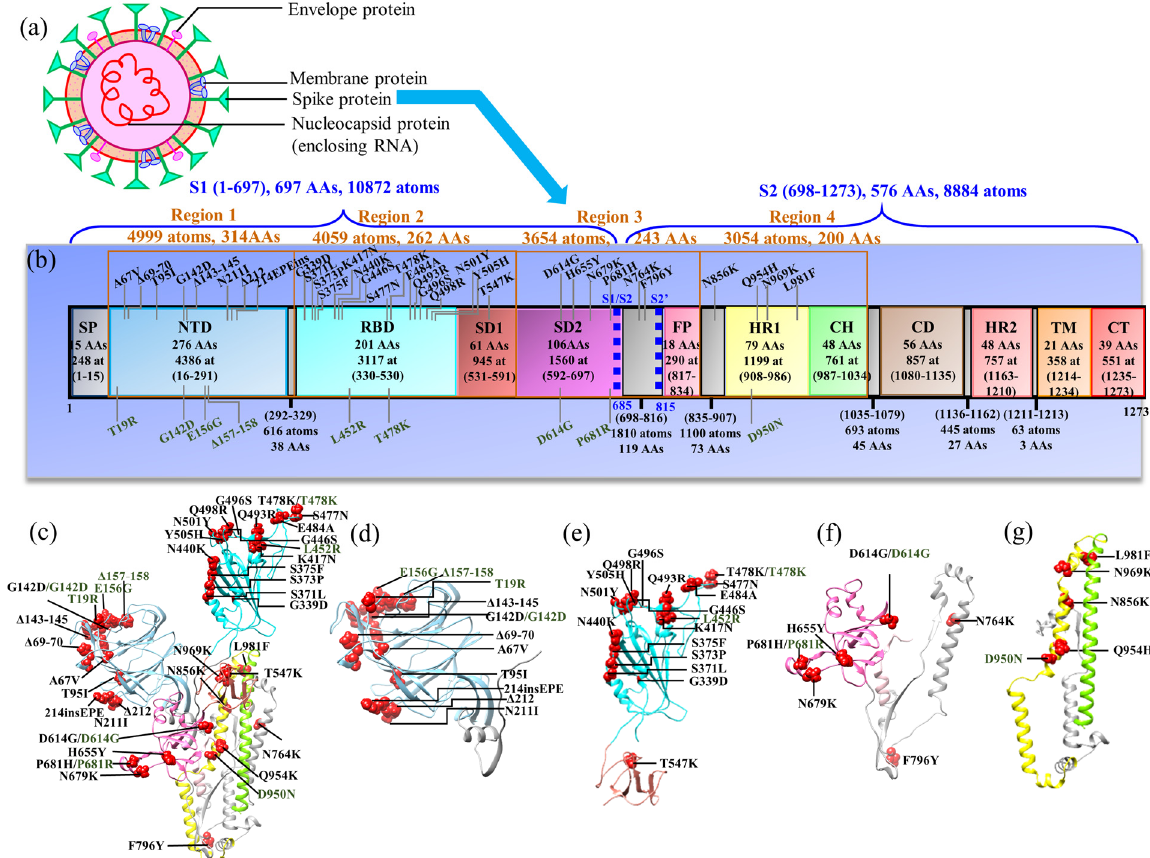
Figure 1. ( a ) Structure of SARS-CoV-2. ( b ) The schematic representation of the S-protein sequence in SARS-CoV-2 (ID: 6VSB) showing four regions of interest. The delta variant (DV) and Omicron variant (OV) are marked at the bottom and the top, respectively. The sequence numbers for the domains are—signal peptide (SP): 1–15; N-terminal domain (NTD): 16–291; receptor binding domain (RBD):